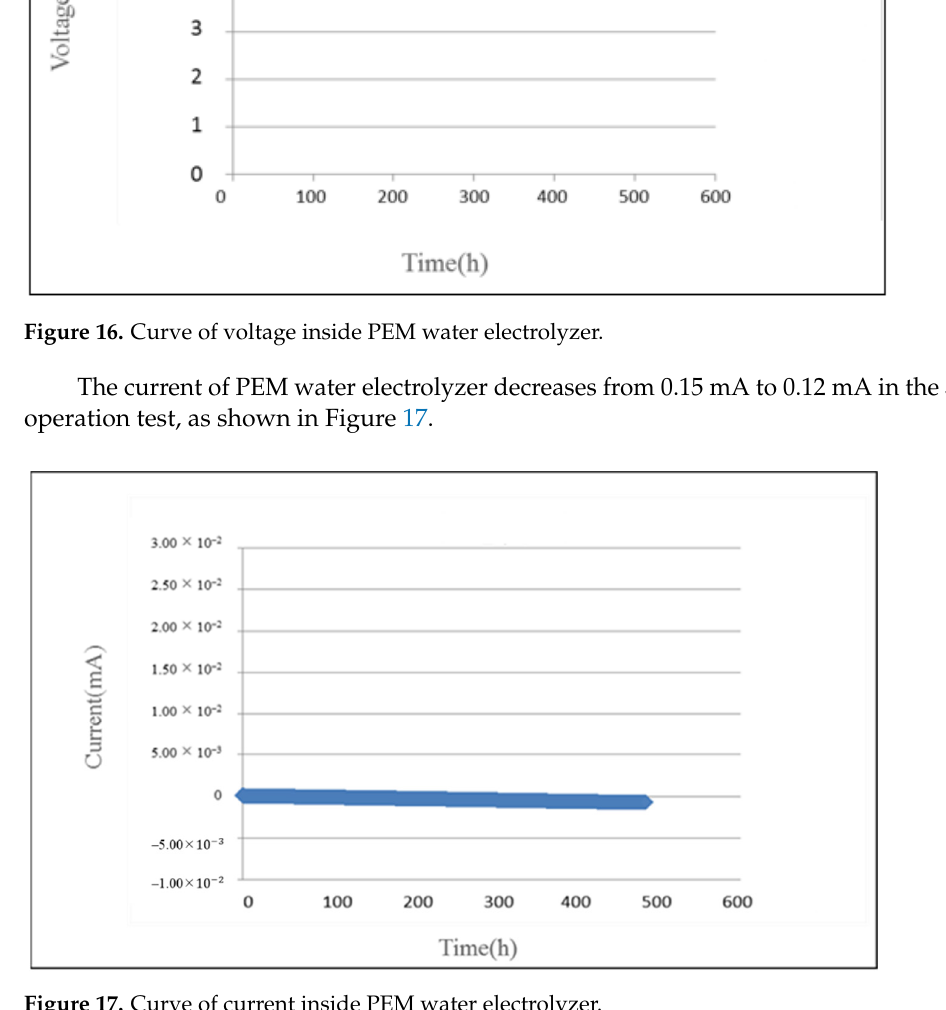
Figure 17. Curve of current inside PEM water electrolyzer. The temperature distribution inside the PEM water electrolyzer is monitored at an operating temperature of 25 ◦ C and constant current. As the water flows through the water electrolyzer continuously, the internal temperature remains at about 25 ◦ C, there is no significant difference, as shown in Figure